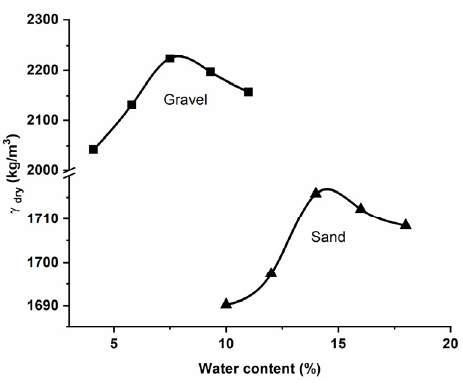
Figure 3. Optimum water content of the gravel and sand used ( note discontinuity and varying scale of the y ‐ axis ).